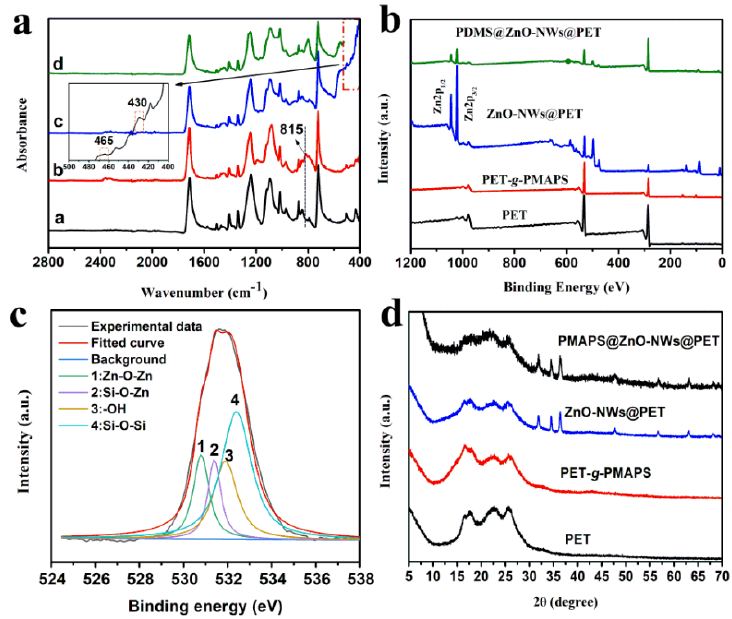
Figure 1. ( a ) Attenuated total reflection (ATR) ‐ FTIR curves of the pristine polyethylene terephthalate (PET) fabric (1), PET ‐ g ‐ PMAPS (2), ZnO ‐ NWs@PET (3), and PDMS@ZnO ‐ NWs@PET (4); wide ‐ scan XPS ( b ) and XRD patterns ( d ) spectra of pristine PET fabric, PET ‐ g ‐ PMAPS, ZnO ‐ NWs@PET, and